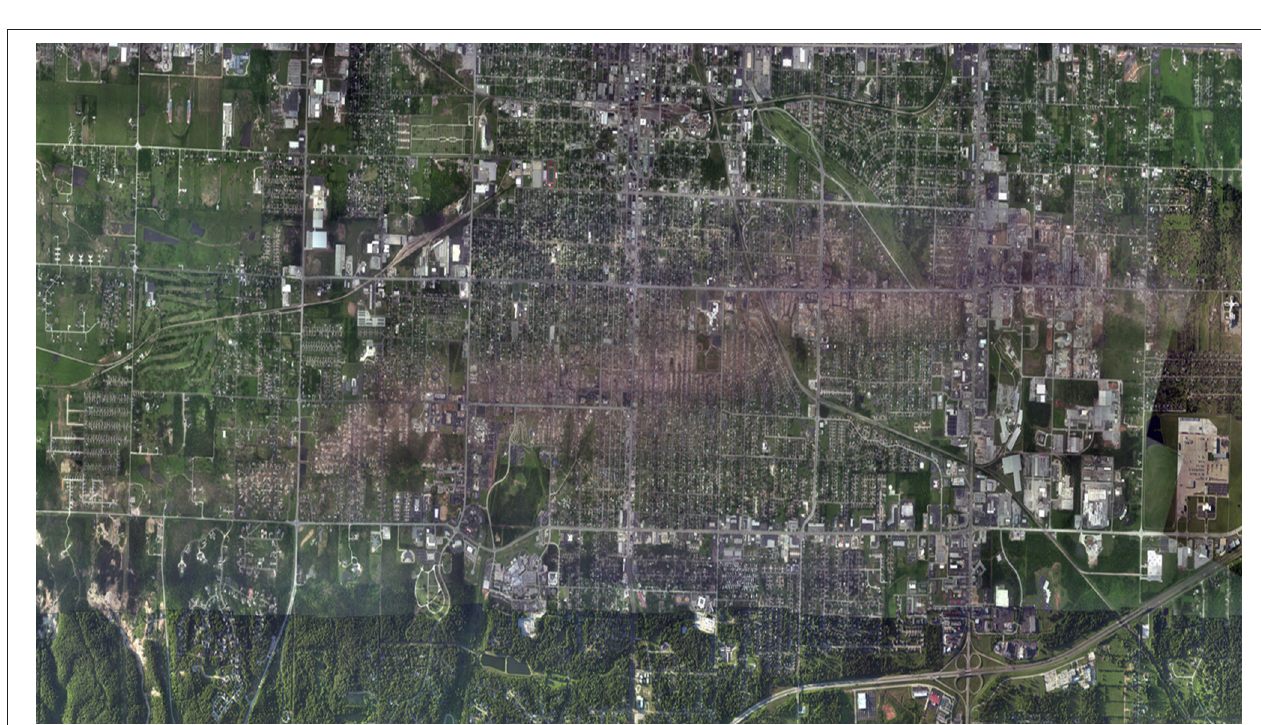
FIGURE 6 | Photomosaic image (created from multiple NOAA 25-cm aerial images) showing path of 2011 Joplin, MO tornado. Image Credit: NOAA (public domain).